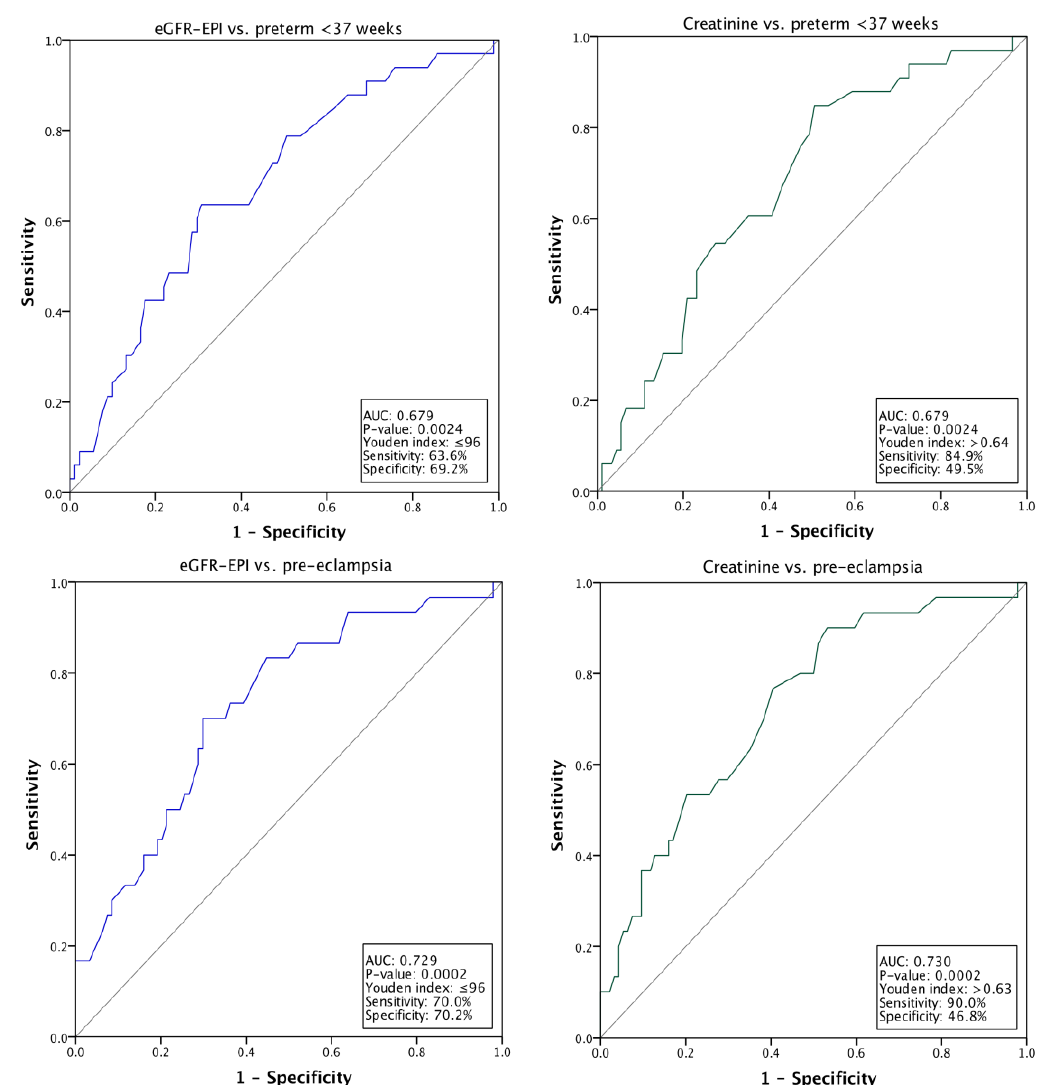
Figure 1. ROC (Relative Operating Characteristic) Curves: relationship between Preterm delivery or Preeclampsia and serum creatinine or eGFR.